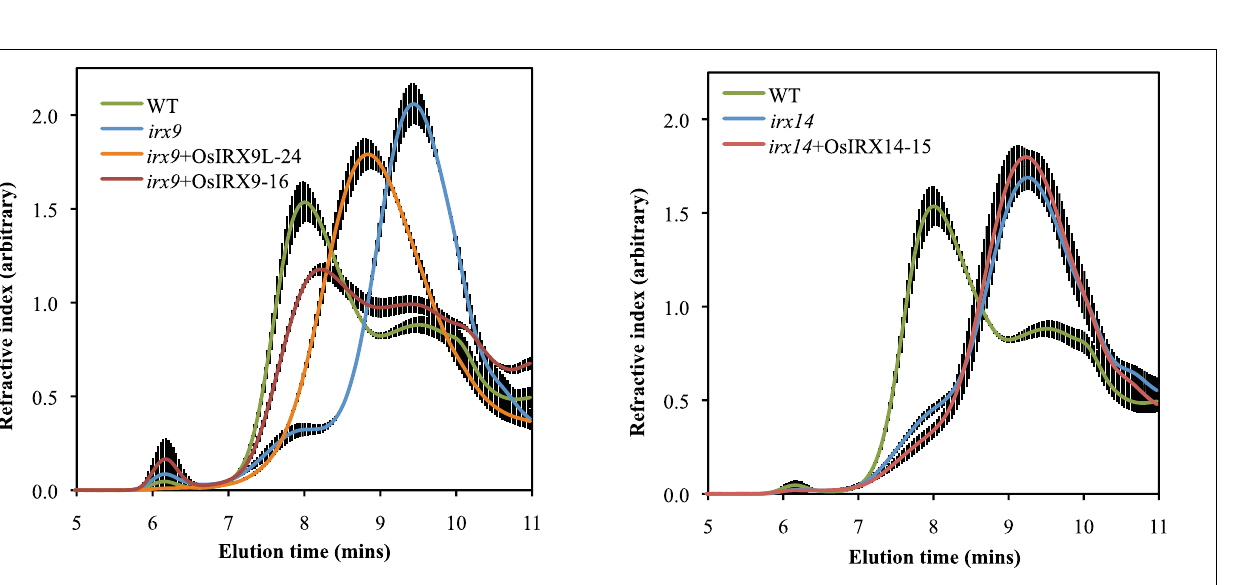
FIGURE 4 | Size-exclusion chromatography (SEC) of mutant, wild type, and complemented lines. Length of xylan chain is measured by elution time (min). Results indicate that the OsIRX9L line has a xylan length that is intermediate between that of wild type and irx9 ;The OsIRX9 complemented